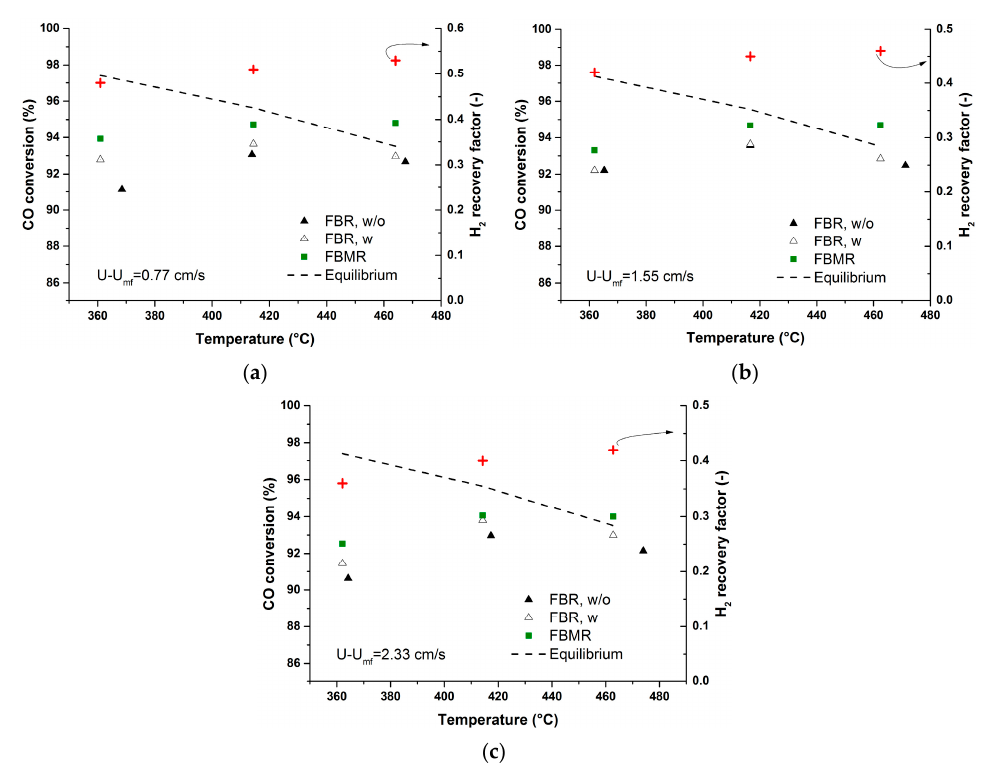
Figure 6. ( a ) Performance of the fluidized bed reactor without internals (FBR, w/o) in comparison with ( b ) fluidized bed reactor with internals (FBR, w) and ( c ) fluidized bed membrane reactor (FBMR) performance at various U-U mf . P: 1 bar, CO (10%), H 2 O (30%), N 2 balance.